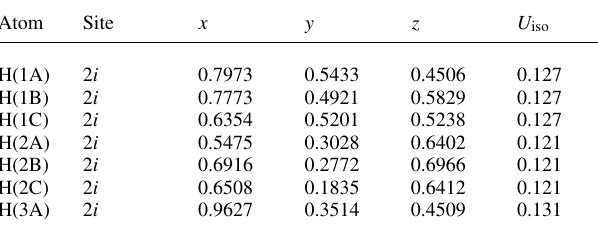
Table 2. Atomic coordinates and displacement parameters (in Å 2 )